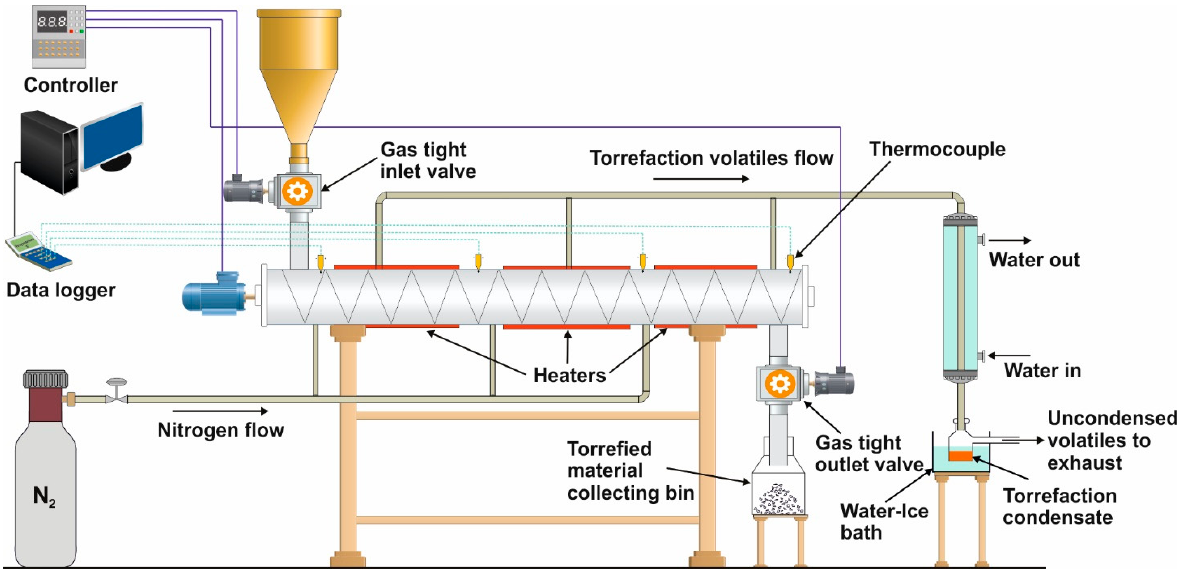
Figure 1. Continuous torrefaction reactor setup used in this